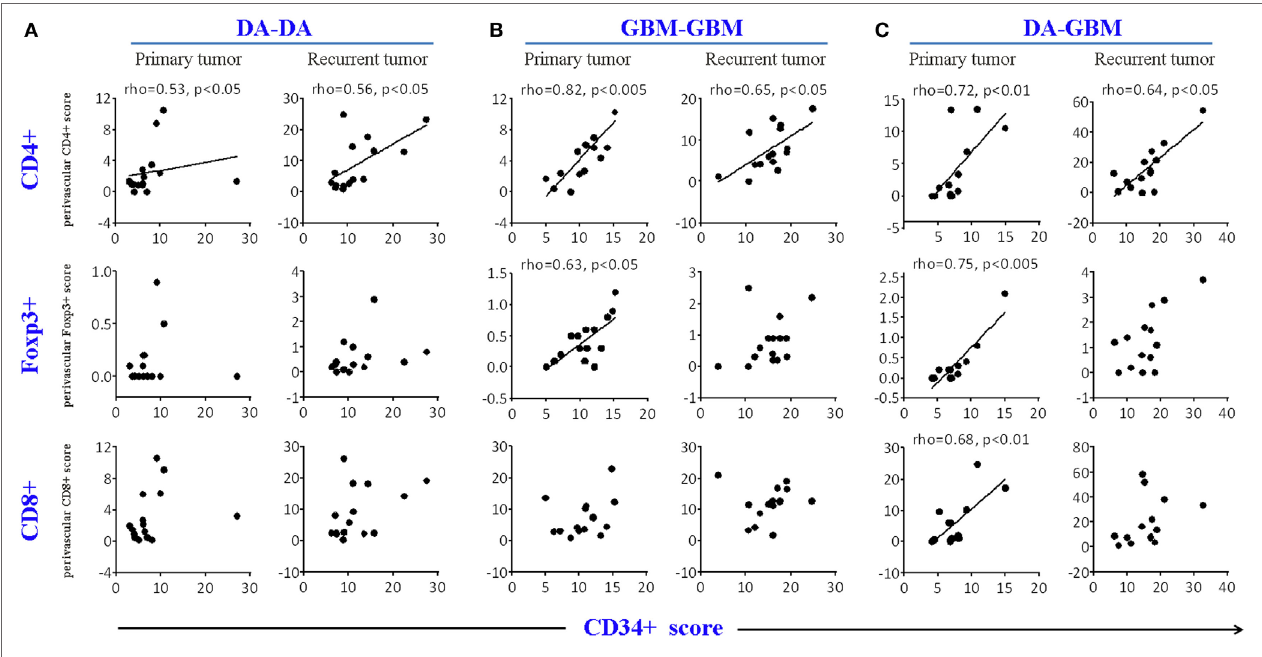
FigUre 2 | A correlation was found between the density of CD34 circles and CD4 + , but not for CD8 + T cells, in primary and recurrent tumors. The correlation CD4 + or CD8 + T cell counts with CD34 circles [average cell or vascular circle counts were obtained from 10 consecutive high powered fields (HPFs)] in primary or recurrent tumors in diffuse astrocytomas (DA)–DA group (a) , GBM–GBM group (B) , and DA–GBM group (c) . Spearman’s rank order correlation analyses were performed and graphs with a correlation (Spearman’s rho ≥ 0.5, p < 0.05) are